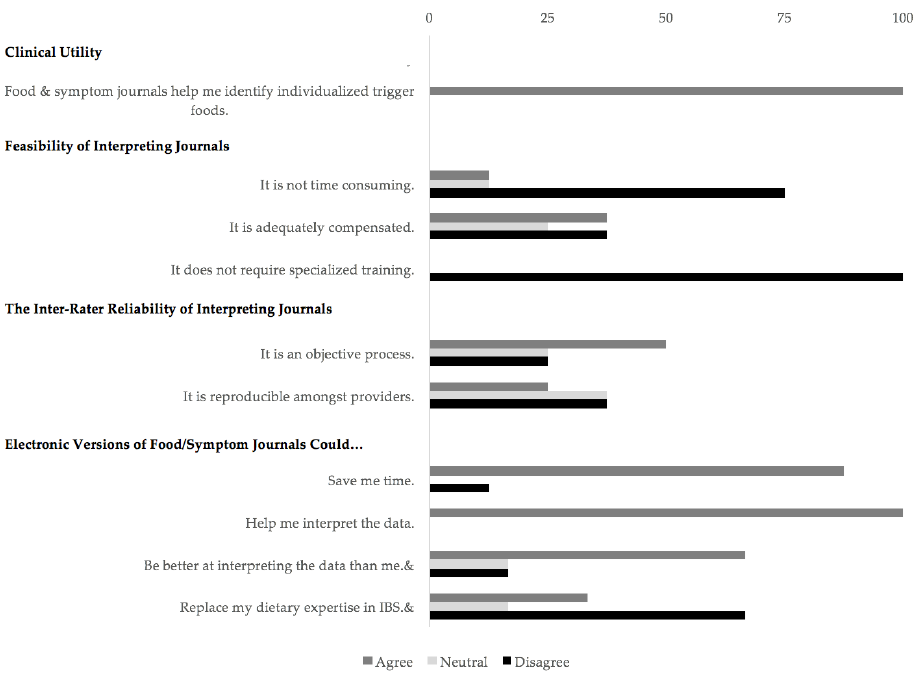
Figure 2. Intake questionnaire: provider perspectives on IBS food and symptom journals: utility, feasibility, inter-rater reliability, and electronic journals. N = 6 (all other responses, N = 8).